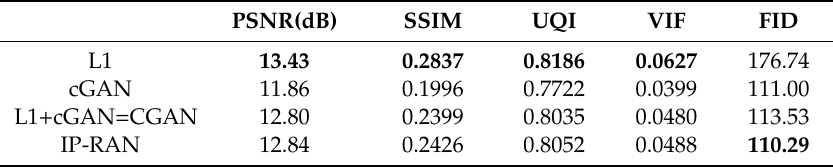
Table 3. Quantitative results compared with di ff erent loss functions.